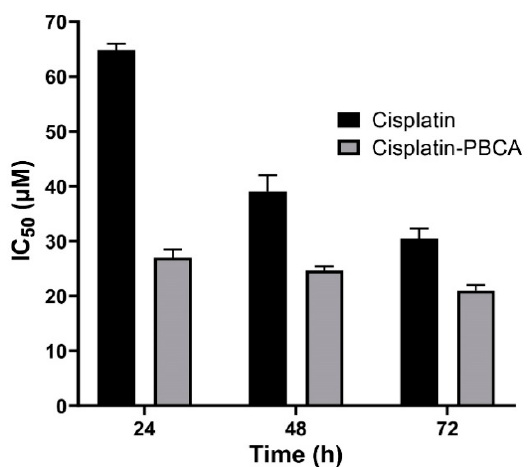
Figure 7. Cytotoxicity effects (IC 50 ) of cisplatin-loaded PBCA nanoparticles (27 ± 1.32, 24.6 ± 1.2, and 21 ± 1.07 µM after 24-, 48-, and 72-h incubation, respectively) compared to the standard drug (64.8 ± 3.22, 39 ± 1.91, and 30.45 ± 1.51 µM after 24-, 48-, and 72-h incubation, respectively) against BHK-21. The data were expressed as mean ± SD (n = 3).